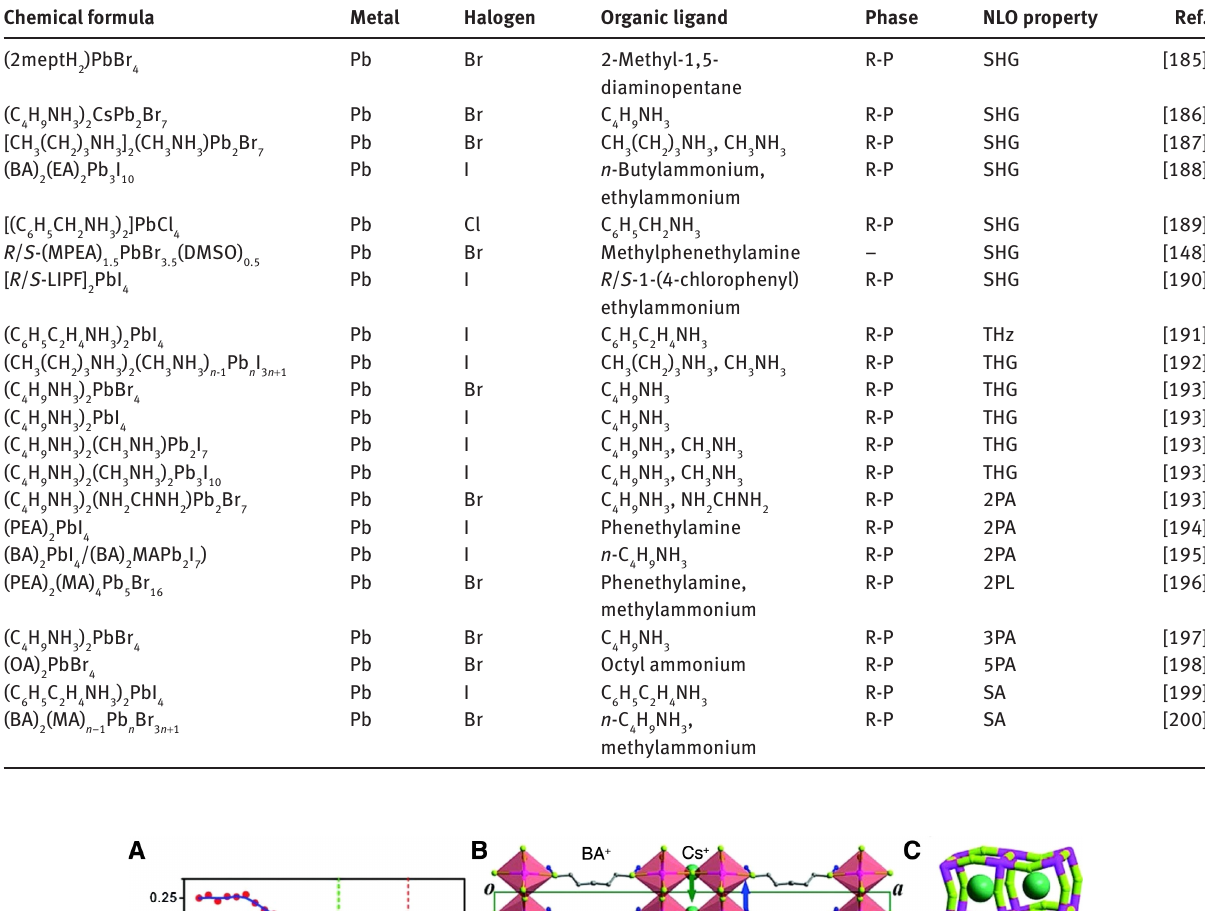
Table 1: 2D perovskites for NLO. Chemical formula Metal Halogen Organic ligand